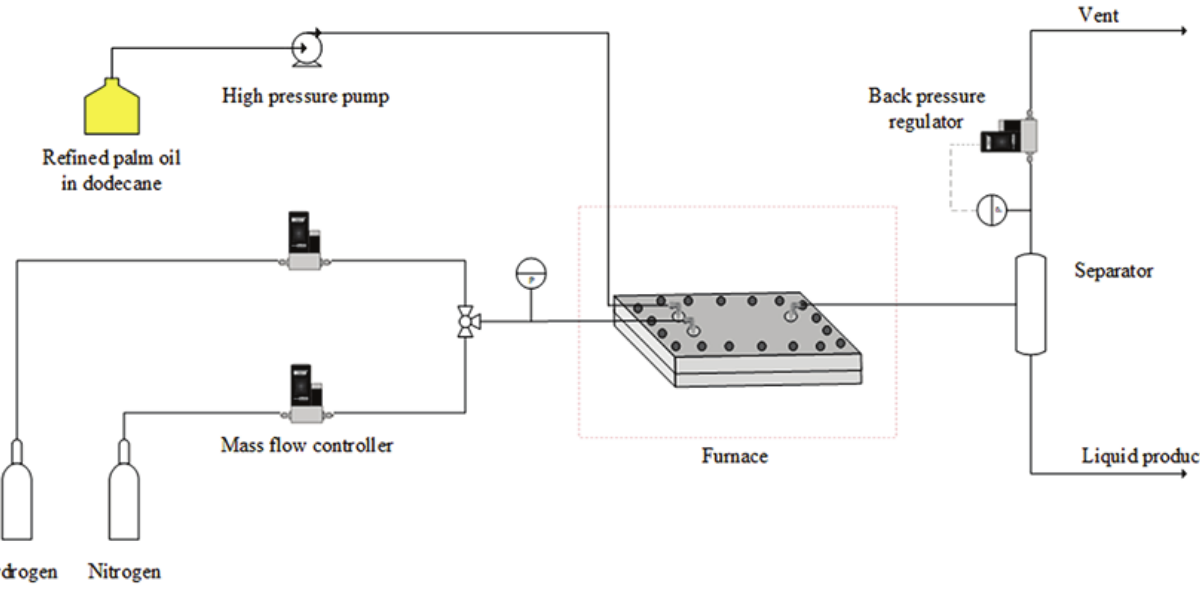
Fig. 2 – Schematic flow diagram of microscale-based reactor